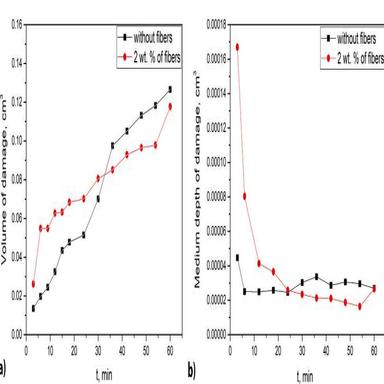
The estimated volume loss of the specimens and corresponding estimates of depth of the surface damages for observed specimens.